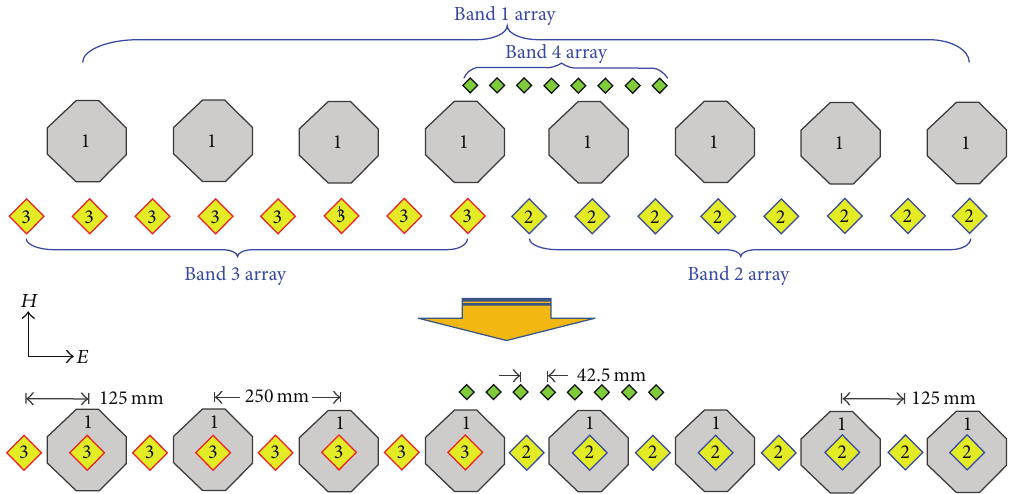
Figure 5: Multiband array design concept for optimal performance and size reduction (1: Band 1 radiator, 2: Band 2 radiator, 3: Band 3 radiator, and 4: Band 4 radiator).